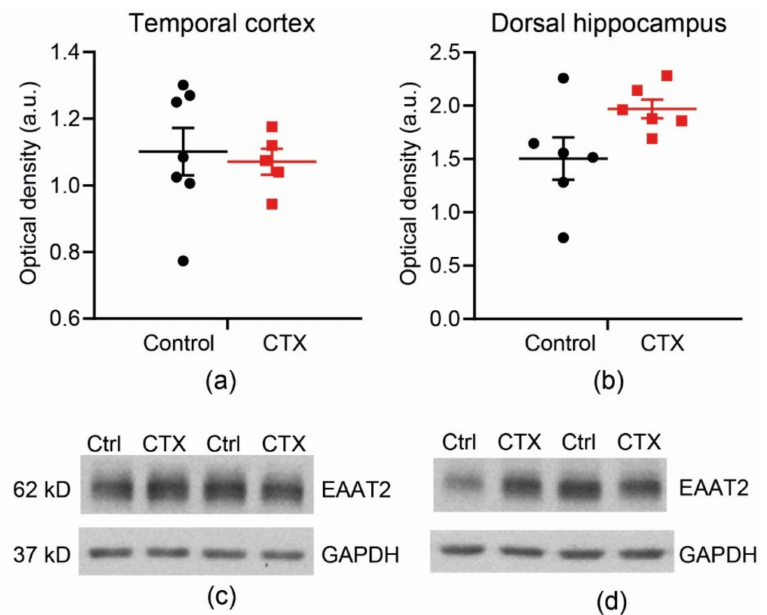
Figure 2. A Western blot analysis, showing no changes in excitatory amino acid transporter 2 (EAAT2) expression in the temporal cortex ( a , c ) and dorsal hippocampus ( b , d ) after 7-day treatment with CTX (200 mg / kg per